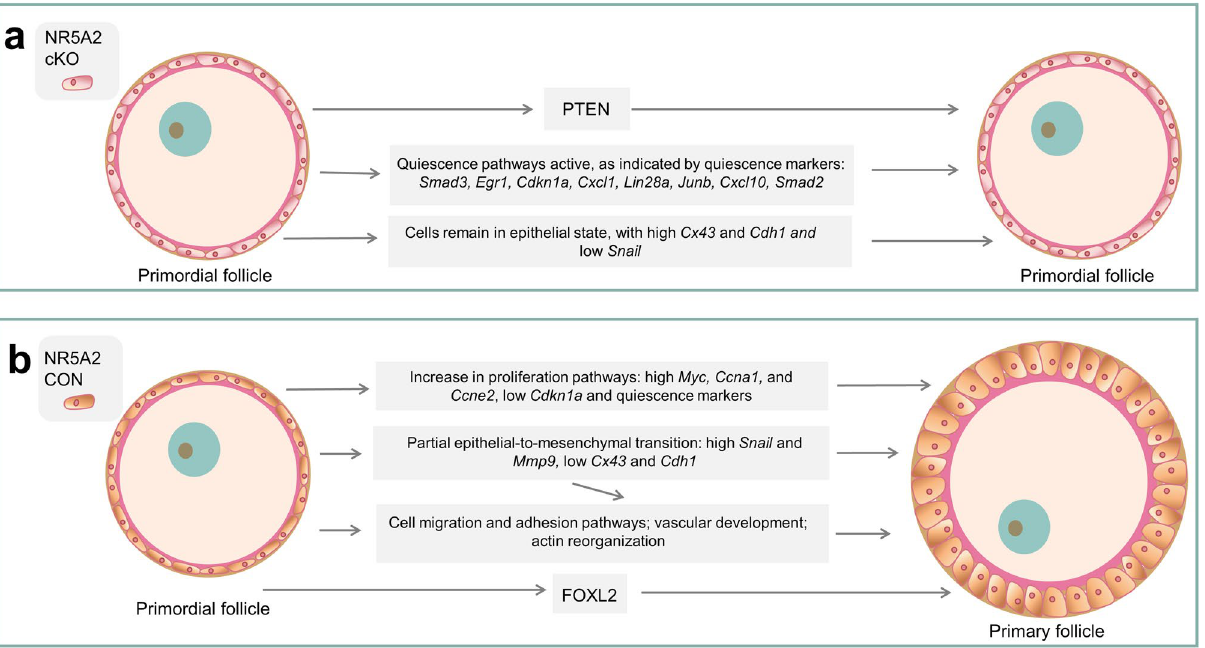
Figure 6. Mechanisms by which NR5A2 regulates follicular activation. ( a ) Mechanisms supporting the suppression of primordial follicle activation in follicles lacking NR5A2. ( b ) Mechanisms leading to activation of primordial follicles that express